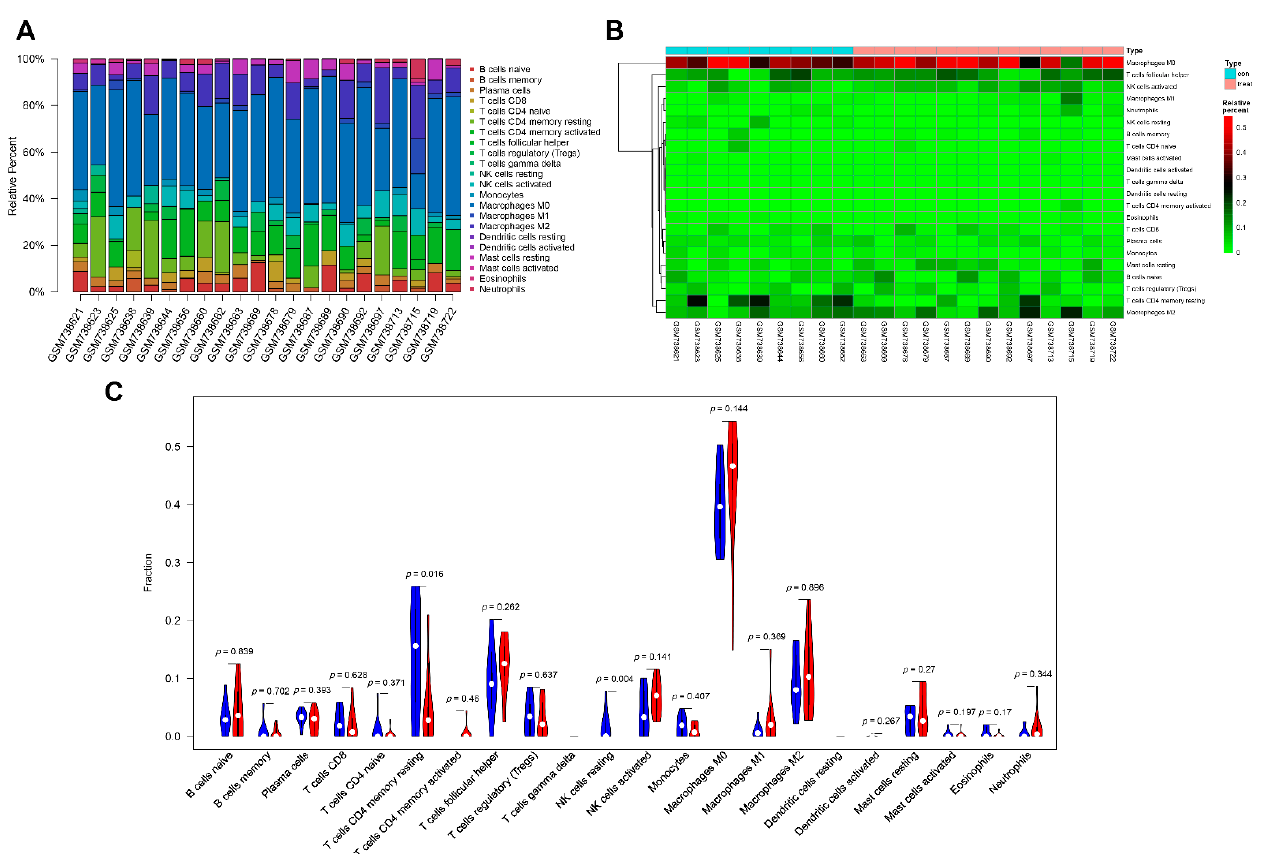
Figure 6. The profile of infiltrating immune cells. ( A ) the proportion of 22 kinds of infiltrating immune cells. ( B ) The heatmaps of the subpopulations of immune cells. ( C ) The violin plot compared the profile of infiltrating immune cells between AMD samples and normal samples; blue represents normal samples and red represents AMD samples.